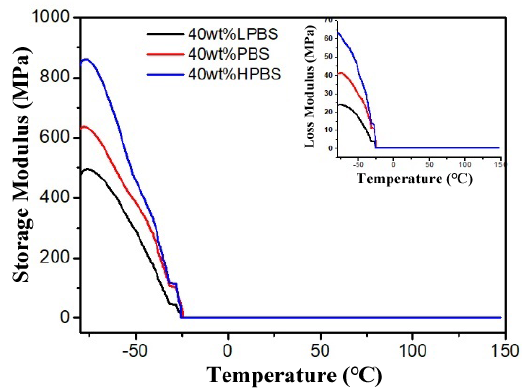
Figure 7. Storage moduls (G ’ ) of LPBS/PBS/HPBS-gel/MVQ composites samples at 1 Hz, the insert curve is corresponding loss moduls (G ’’ ) of LPBS/PBS/HPBS-gel/MVQ composites samples at 1 Hz.